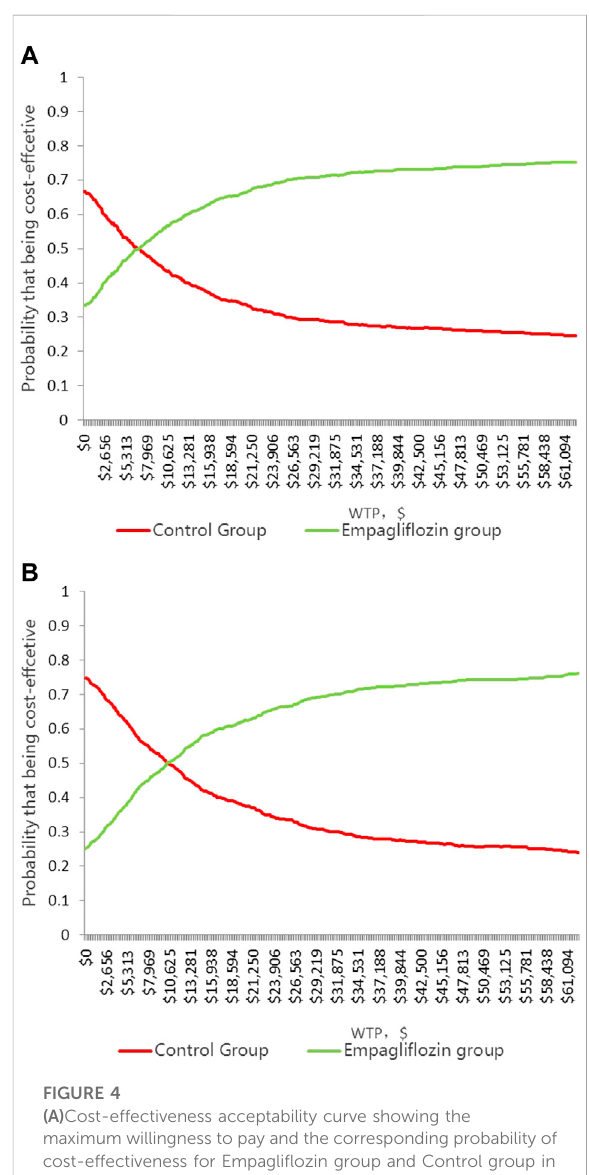
FIGURE 4 (A) Cost-effectiveness acceptability curve showing the maximum willingness to pay and the corresponding probability of cost-effectiveness for Empagli fl ozin group and Control group in HFrEF population. (B) Cost-effectiveness acceptability curve showing the maximum willingness to pay and the corresponding probability of cost-effectiveness for Empagli fl ozin group and Control group in HFpEF